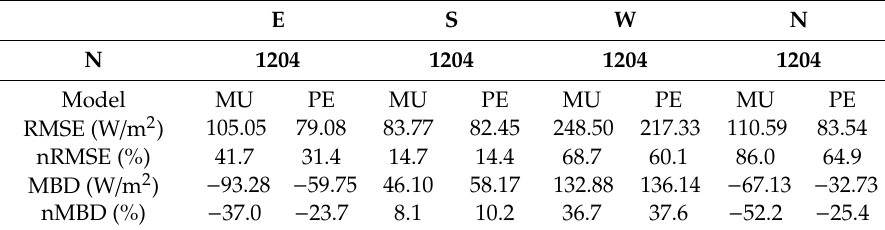
Table 7. Statistic values under clear sky conditions for NREL